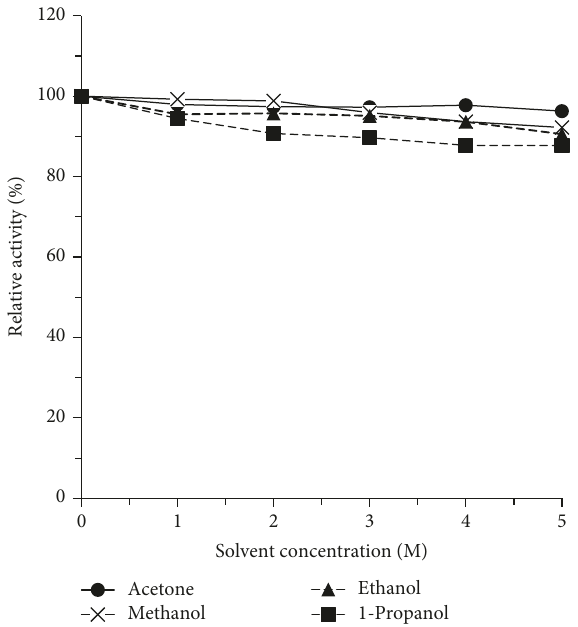
Figure 7: Effects of NaCl on XynA MG 1 activity and stability. The xylanase activity at the starting time and without NaCl added was taken as 100%. The data were presented as mean ± SD ( 𝑛 = 3 ) (for experimental details, please see the main text).